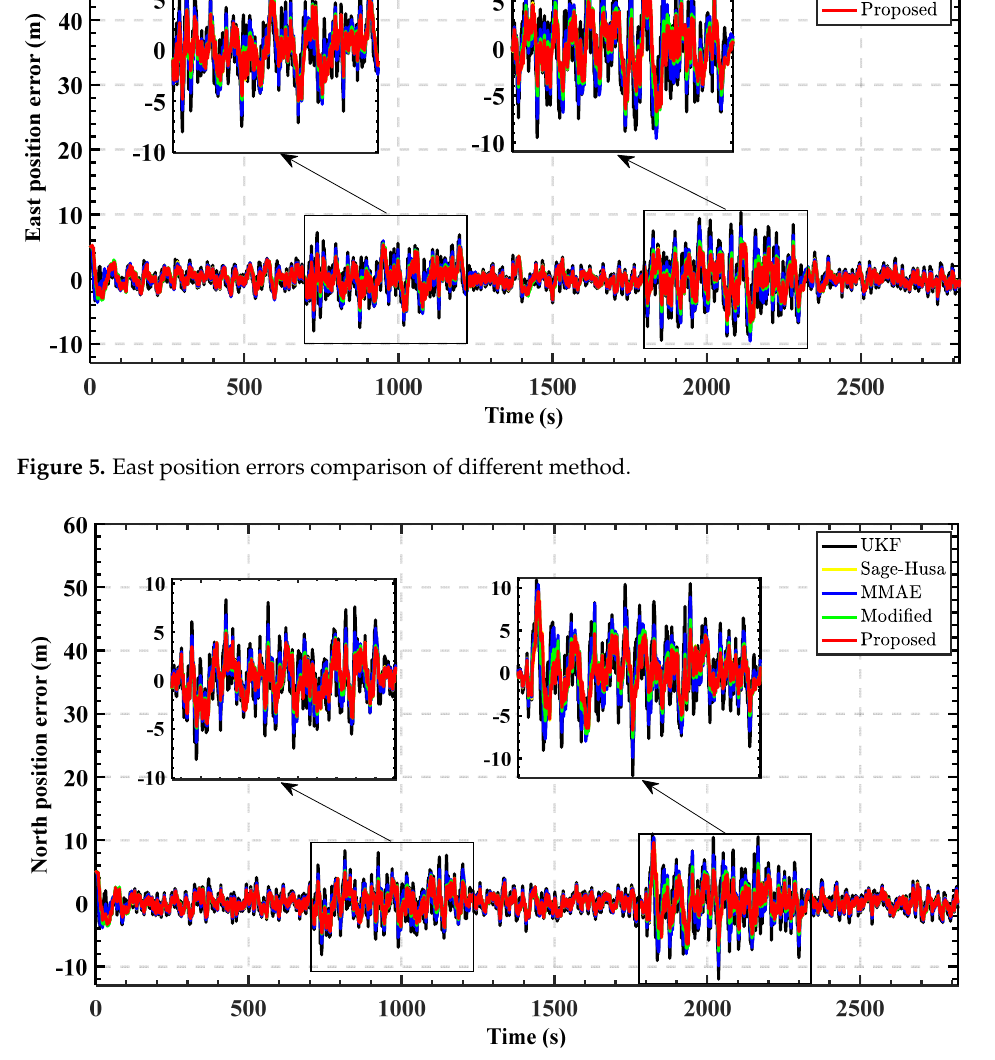
Figure 6. North position errors comparison of different method. Table 4. MSE of position errors of different